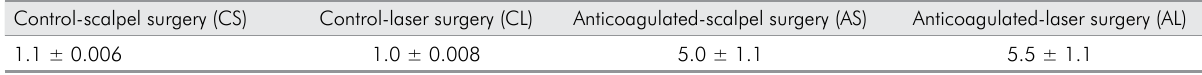
Table 1. Mean and standard deviation of INR values in control and experimental groups. Control-scalpel surgery (CS)